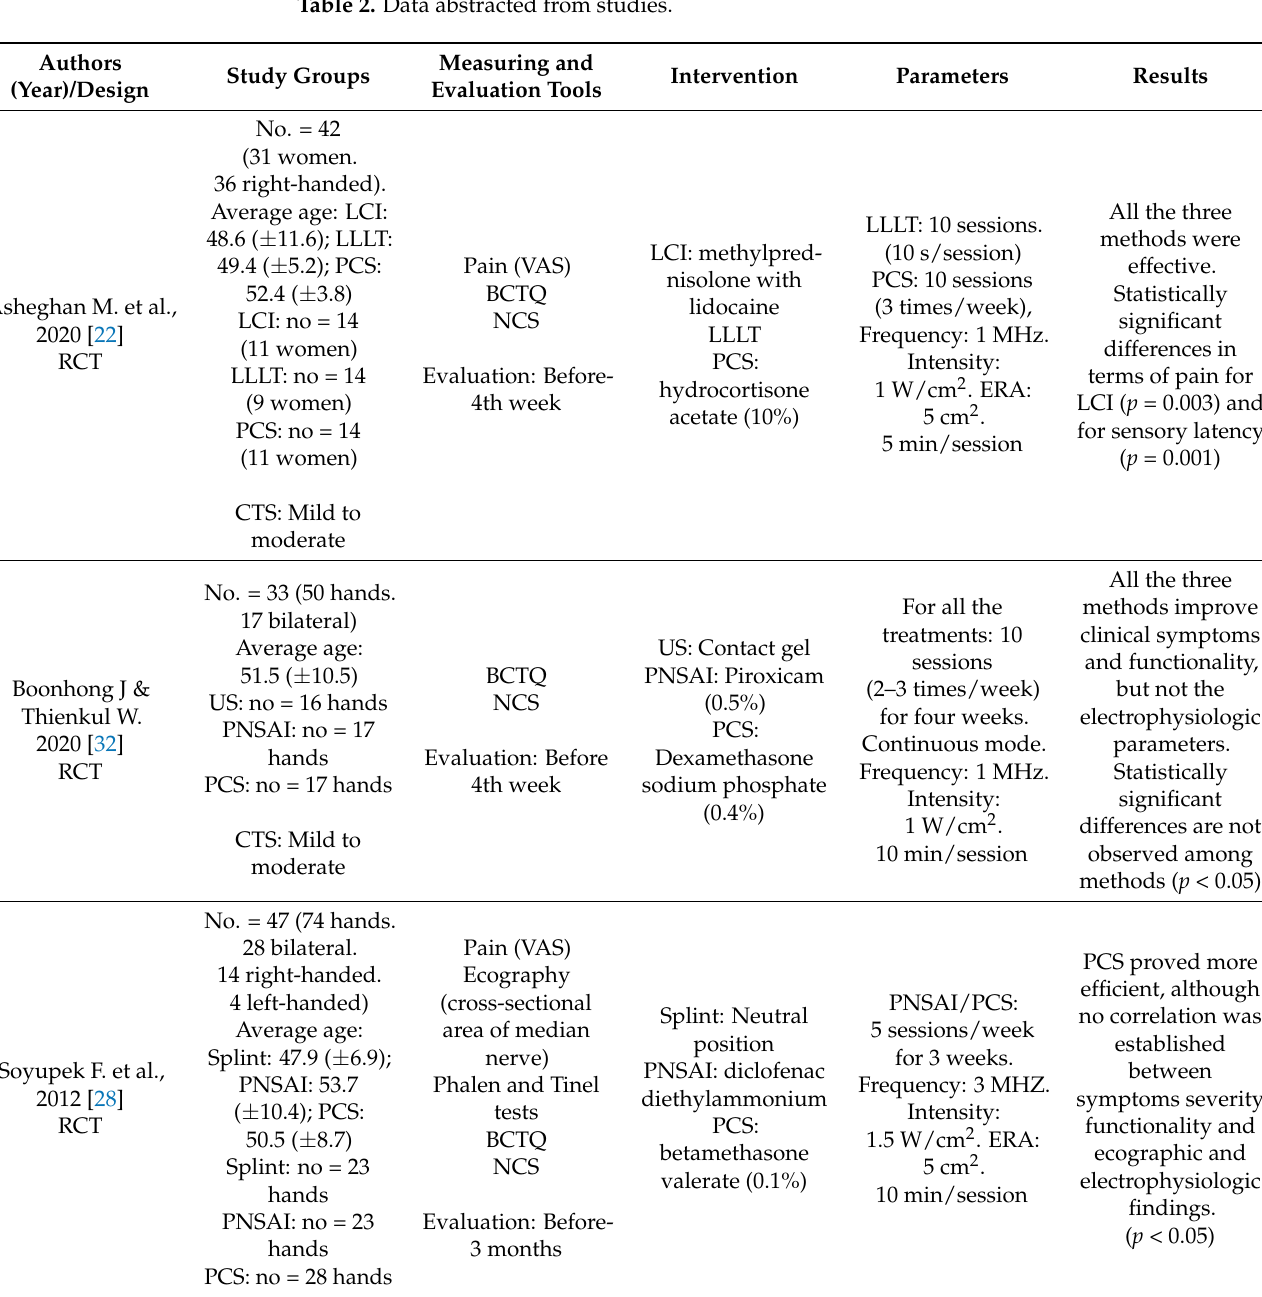
Table 2. Data abstracted from